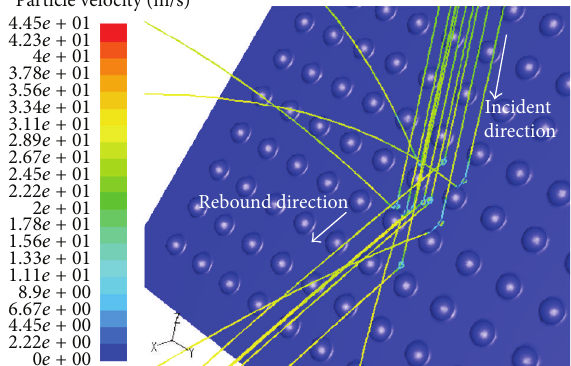
Figure 10: The trajectories of particle collision convex